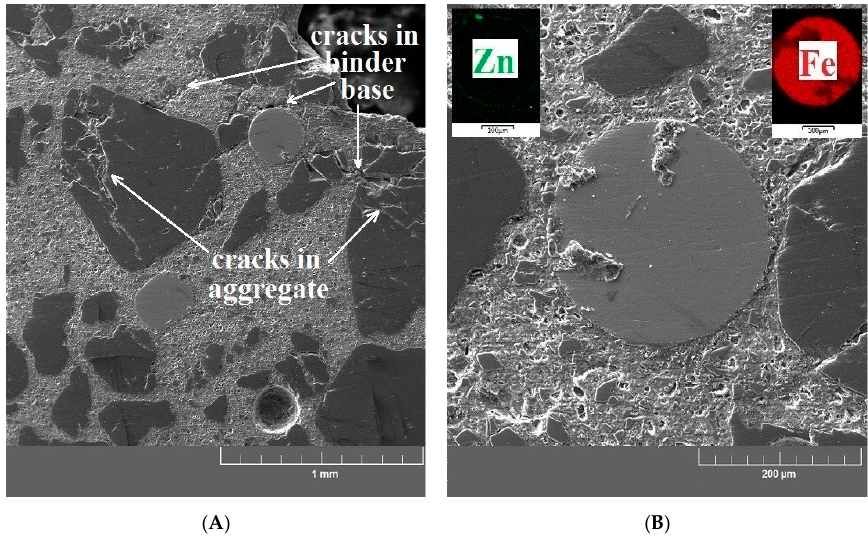
Figure 17. ( A ) SEM image of a sample after exposure to 400 °C focused on the UHPC matrix/aggregate interfacial transition zone. ( B ). SEM image of a sample after exposure to 400 °C focused on the brass-coated steel fiber/UHPC matrix interfacial transition zone.